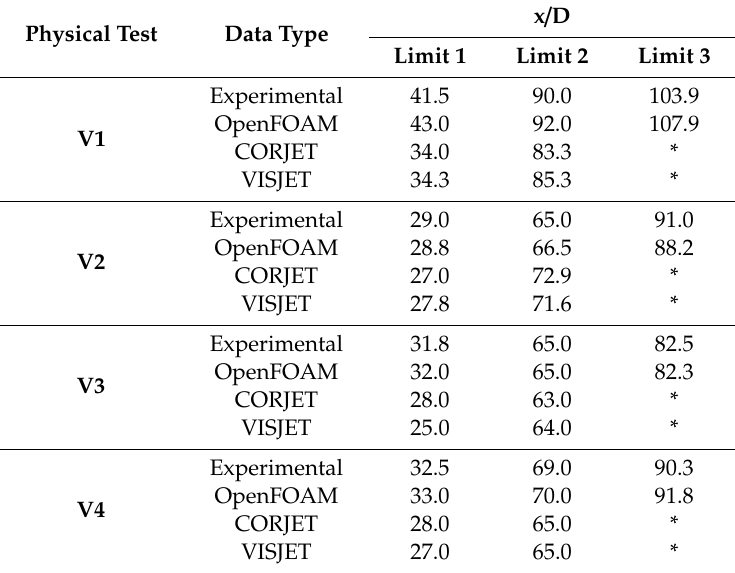
Table 3. Summary of the limits of positively buoyant jet zones defined by the physical (Experimental) and the numerical (OpenFOAM, CORJET, VISJET) modelling.